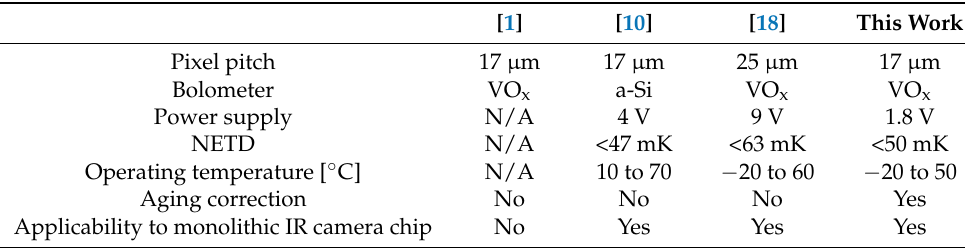
Table 3. Performance